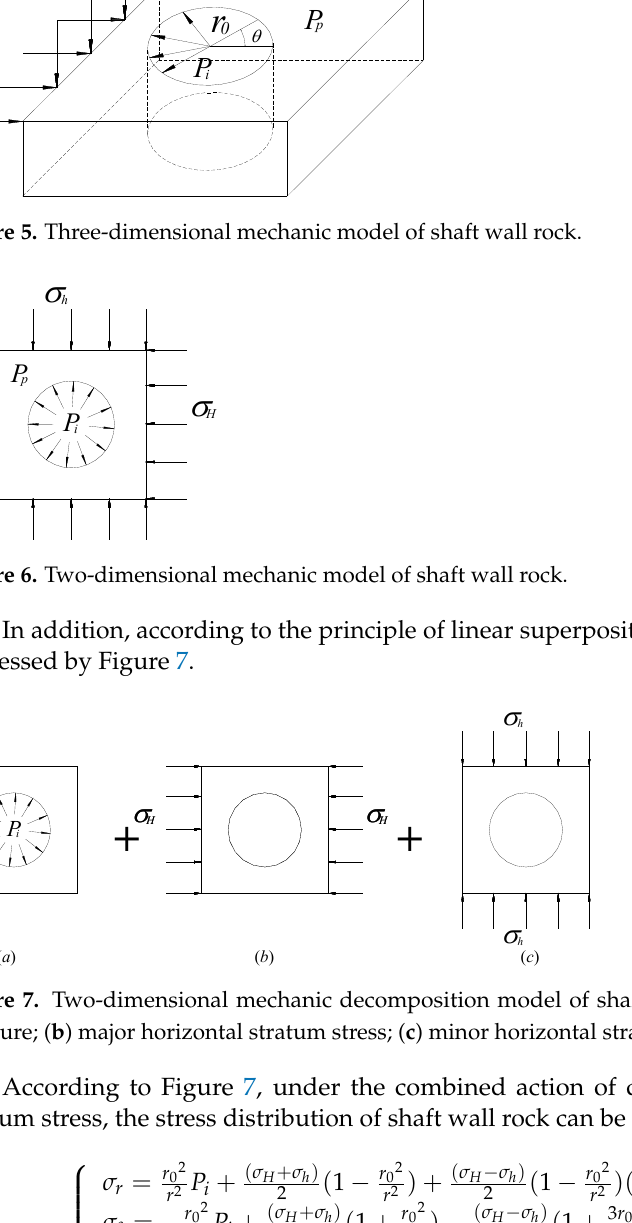
Figure 5. Three ‐ dimensional mechanic model of shaft wall rock .